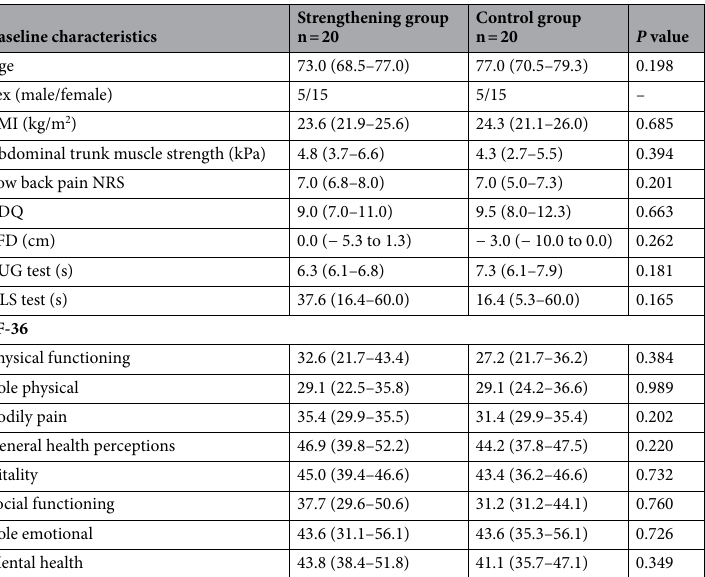
Table 1. Baseline characteristics of participants in both groups. Data are shown as the median and interquartile range or as the number as appropriate. BMI body mass index, NRS numerical rating scale, RDQ The Roland Morris Disability Questionnaire, FFD Finger-floor distance, TUG Timed up and go, OLS one-leg standing, SF‑36 Short-Form